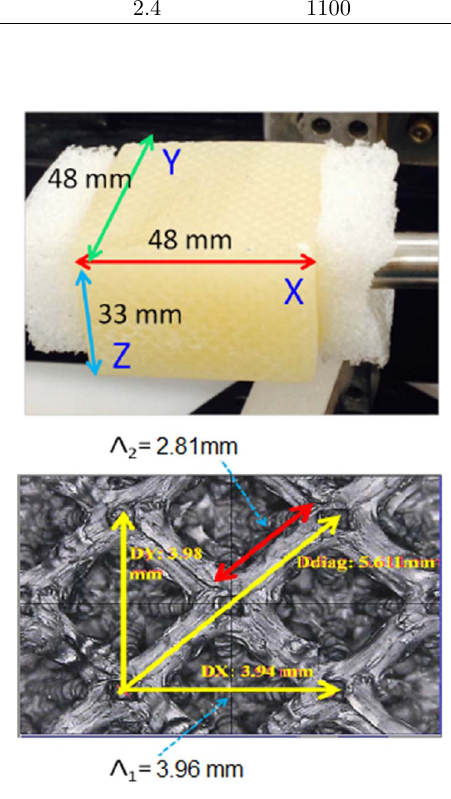
and its dimensions. (Bottom) Image of the sample surface and the dimensions of a component cell. The image was obtained using a pro fi lometer.